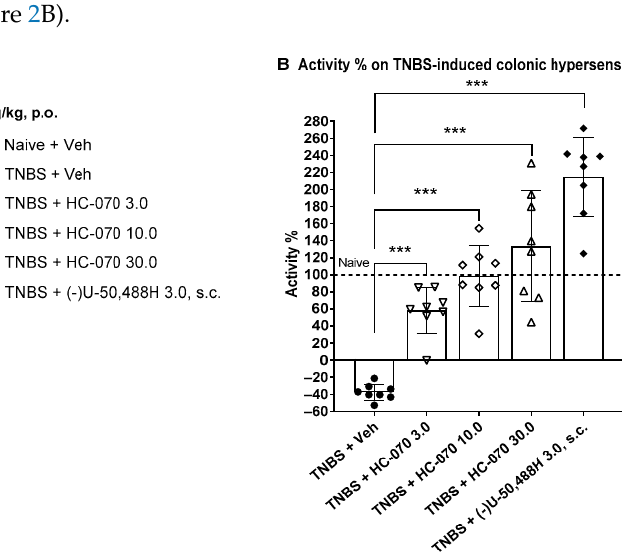
Figure 2. Effect of a single HC-070 (mg/kg, p.o.) administration on hypersensitivity in the rat model of trinitrobenzene sulfonic acid (TNBS)-induced chronic colonic hypersensitivity. ( A ) The colorectal distension test was performed 30 min, 50 min, 70 min, and 120 min after HC-070/Vehicle/( − )U- 50,488H treatment. Results of colonic distension threshold (mmHg) evoked by the colorectal disten- sion test are expressed as mean, the error bars represent SD, n = 8/treatment group. One symbol indicates treatment p < 0.05, two symbols p < 0.01, and three symbols p < 0.001, as compared to the vehicle-treated TNBS group, Dunnett’s test after two-way repeated measures ANOVA or Dunn’s test after the Kruskal–Wallis test. ( B ) Results of percentual colonic anti-hypersensitivity activities of HC-070 or percentual variation of TBNS + Veh vs. naive animals are expressed as mean of four trials, the error bars represent SD, n = 8/treatment group, and each symbol represents an individual data point. ***, p < 0.001, as compared to the vehicle-treated TNBS group, Dunnett’s test after significant one-way ANOVA. 2.3. Colonic Anti-Hypersensitivity Effect of TRPC4/5 Antagonist HC-070 in the Model of Partial Restraint Stress in Female Rats Results of the colonic distension threshold (mmHg), evoked by gradually increased intra-colonic pressure to induce a pain-related behavioral response, are expressed as the mean of three trials. Partial restraint stress (PRS) induced statistically significant colonic hypersensitivity (F5,54 = 25.12, p < 0.0001; p < 0.0014, post hoc test between PRS and naïve groups; Figure 3A). The naïve colonic distension threshold was in the range of 36 mmHg, while partial restraint stress decreased the colonic distension threshold to a level of 27 mmHg. The percentual variation due to partial restraint stress as compared to naïve rats was − 25% (Figure 3A). Furthermore, post hoc testing indicated that normal colonic sensi- bility was dose-dependently restored after oral HC-070 doses of 3, 10, and 30 mg/kg by percentual anti-hypersensitivity activities at a colonic hypersensitivity of 100%, 181%, and 188%, respectively. Additionally, subcutaneously administered morphine at 1 mg/kg in- duced significant reversal of the lowered visceral pain threshold in response to colonic distension. The corresponding percentual anti-hypersensitivity activity on the colonic hy- persensitivity of morphine was 272% (Figure 3A).